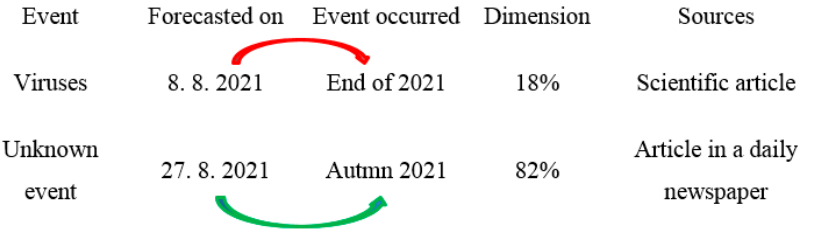
Figure 3. Ex-ante research on predicted “tsunami” at the end of February 2022. Sources: Gricar et al. (2022).